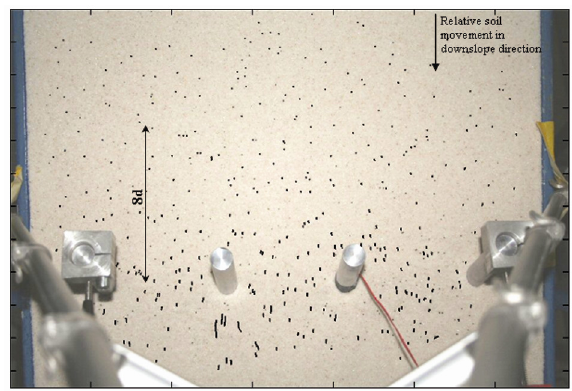
Fig. 7. The overall relative soil surface displacements throug- hout the test the free head pile test with s/d = 6